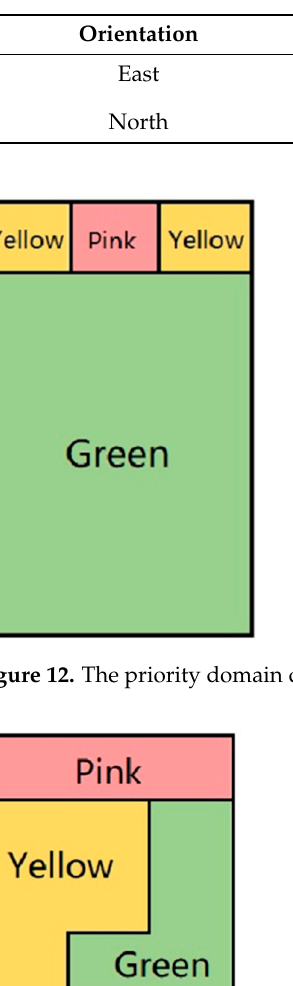
Table 10. The weights of 𝑈𝐷𝐼 (cid:2872)(cid:2873)(cid:2868)(cid:2879)(cid:2870)(cid:2868)(cid:2868)(cid:2868)(cid:2922)(cid:2931)(cid:2934) [50%] and 𝑈𝐷𝐼 (cid:2870)(cid:2868)(cid:2868)(cid:2868)(cid:2922)(cid:2931)(cid:2934) [50%] in each orientation room.